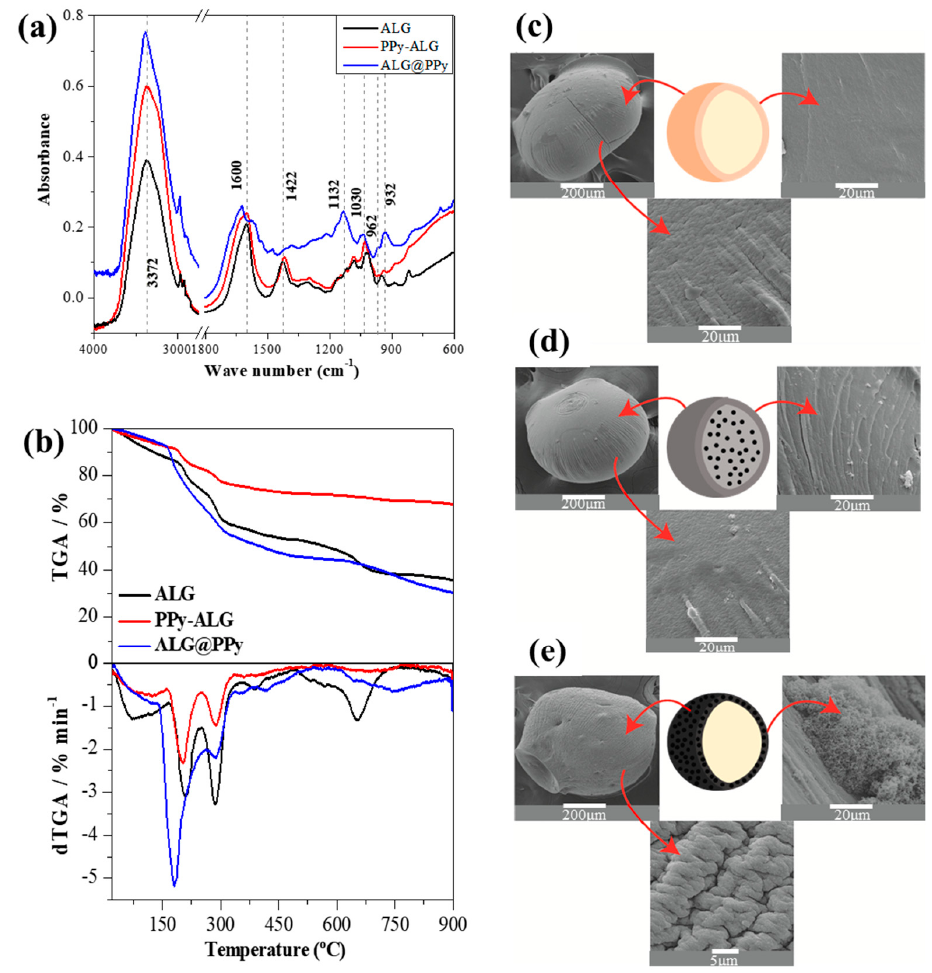
Figure 2. ( a ) ATR-FTIR spectra of the ALG, PPy-ALG and ALG@PPy hydrogels disks. ( b ) TGA and dTGA curves for ALG, PPy-ALG and ALG@PPy hydrogels. SEM images showing the morphology of ( c ) ALG, ( d ) PPy-ALG and ( e ) ALG@PPy hydrogels.